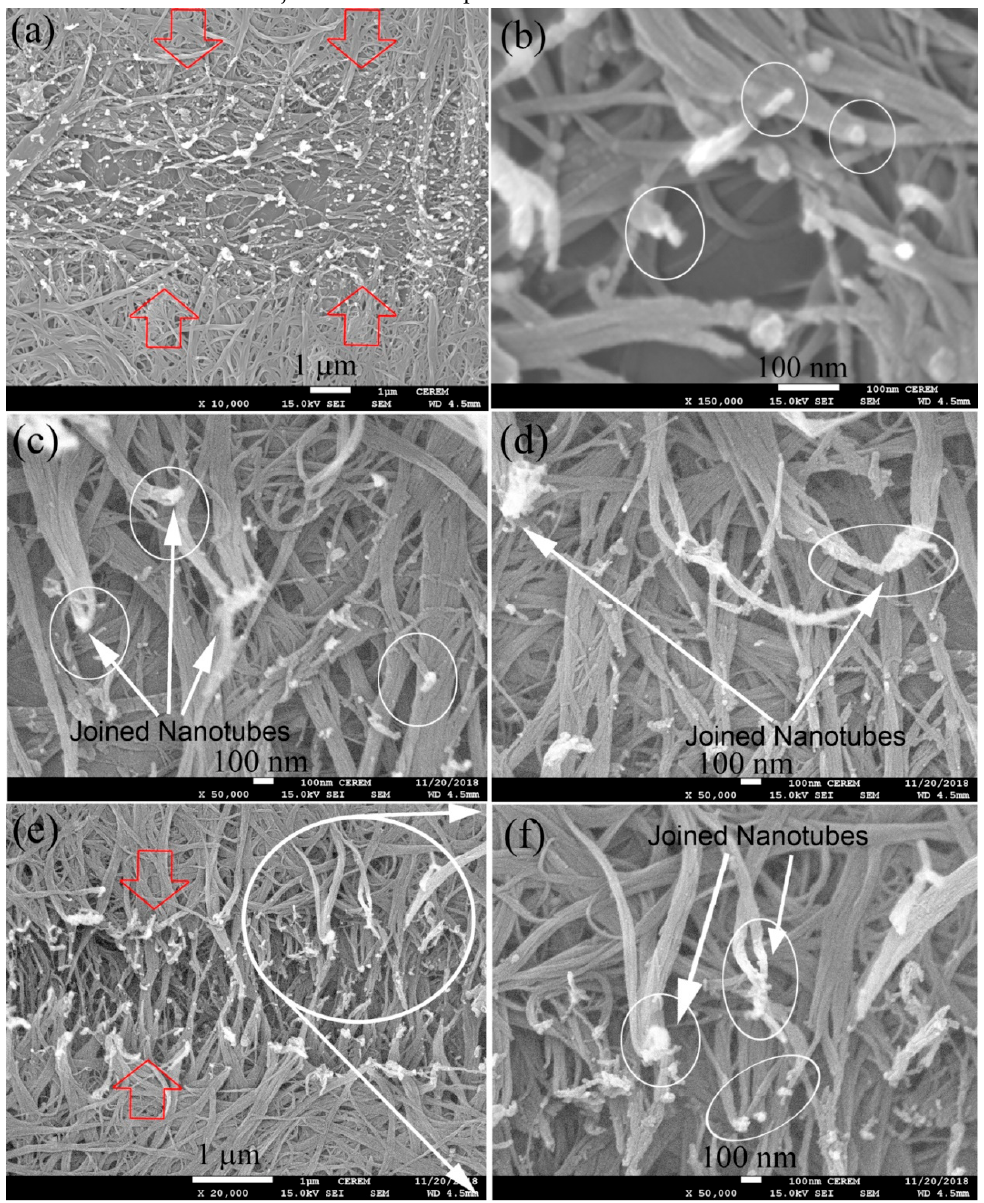
Figure 4. SEM images of SWCNTs sample after irradiation with ( a , b ) green wavelength (GR) with a fluence of 848.85 J /cm 2 with 15 mm lens; ( c , d ) GR with a fluence of 541.14 J /cm 2 with 10X Zeiss lens, and ( e , f ) GR with a fluence of 2705.71 J /cm 2 with 10X Zeiss lens.